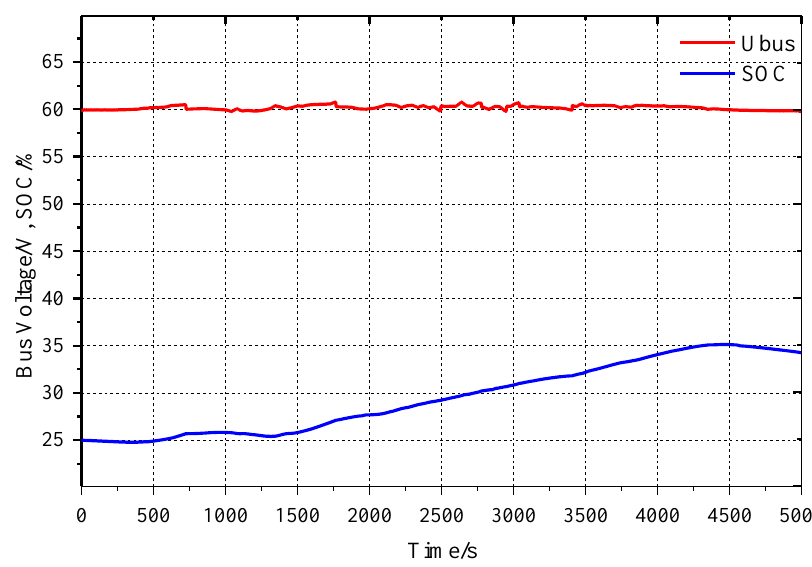
Figure 10. The bus voltage and SOC of the battery bank in Case I.